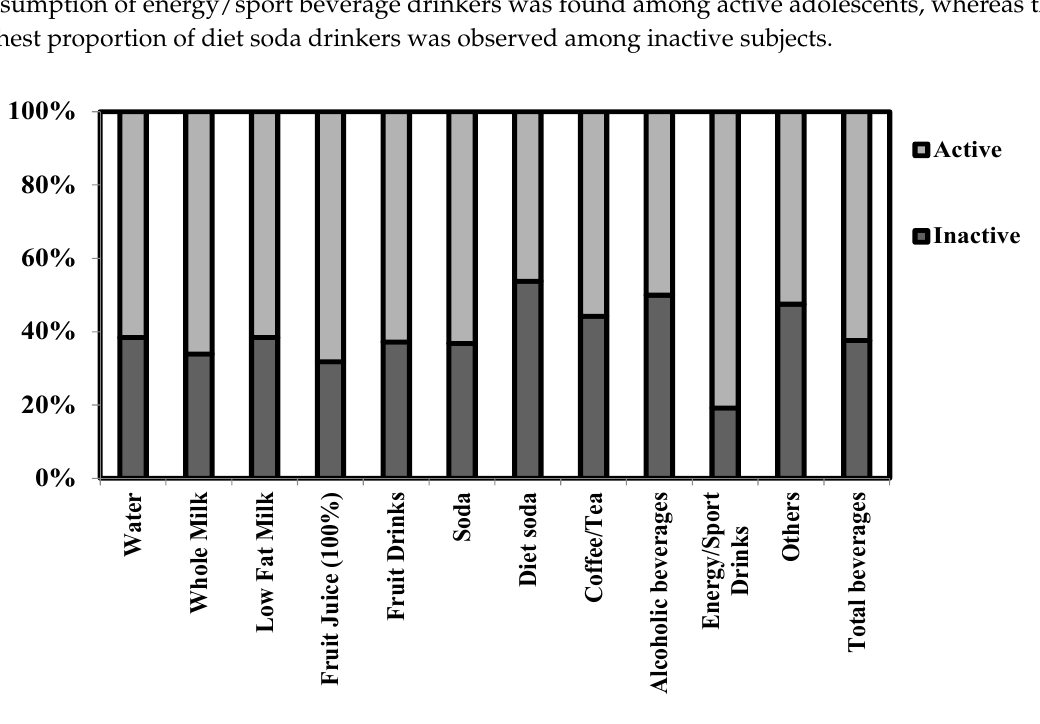
Figure 1. Proportions of consumers of each beverage according to physical activity level (others include carrot juice, beer without alcohol, chocolate milkshake, vanilla milkshake, strawberry milkshake, diet milkshake, soy milk, rice milk, oat milk, fermented milk drink with sugar, fermented milk drink, kefir, horchata, and sugar added iced tea).